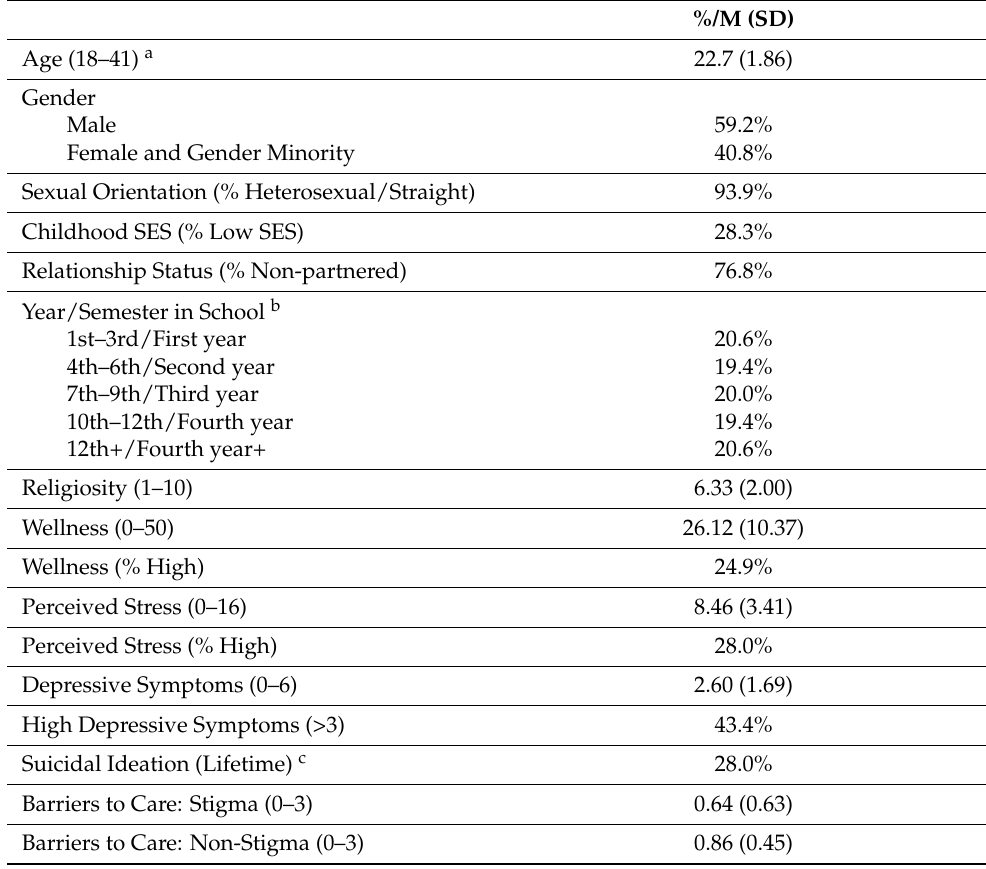
Table 2. Participant Characteristics ( n =